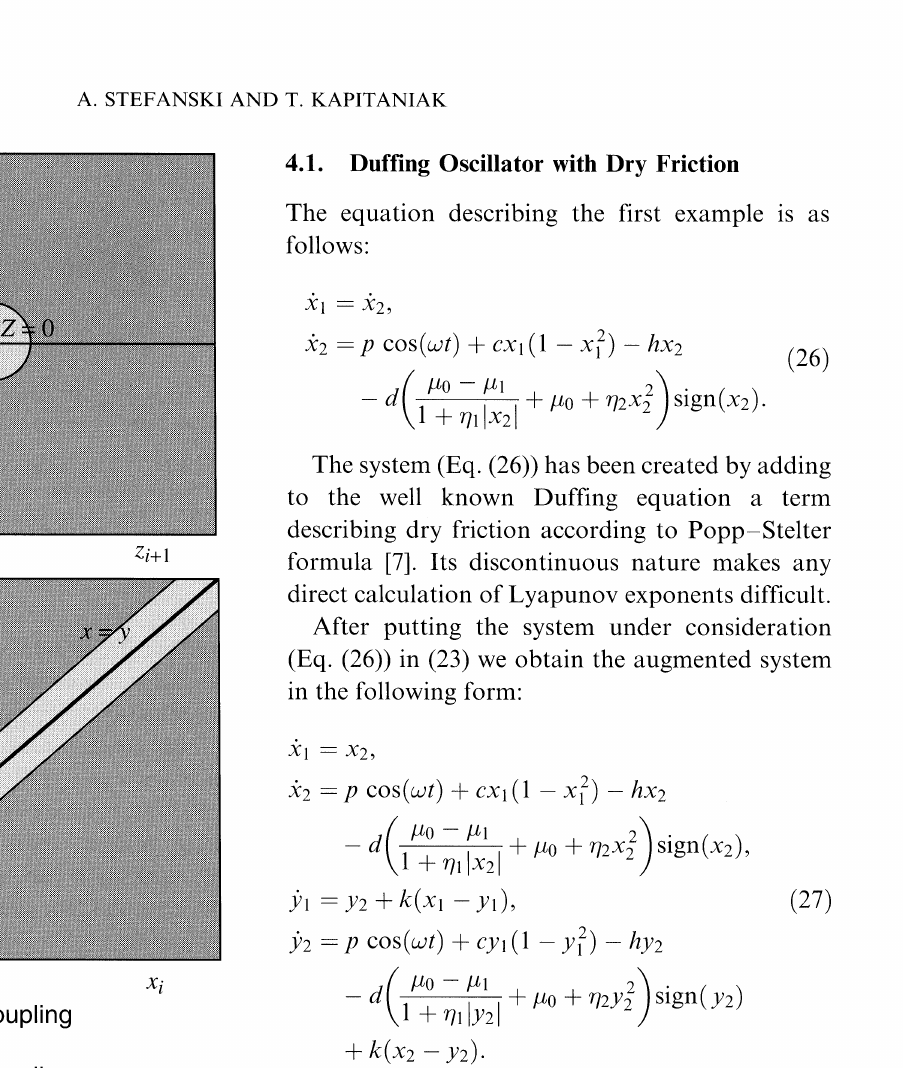
FIGURE 4 The idea of elastic coupling (see description in Section